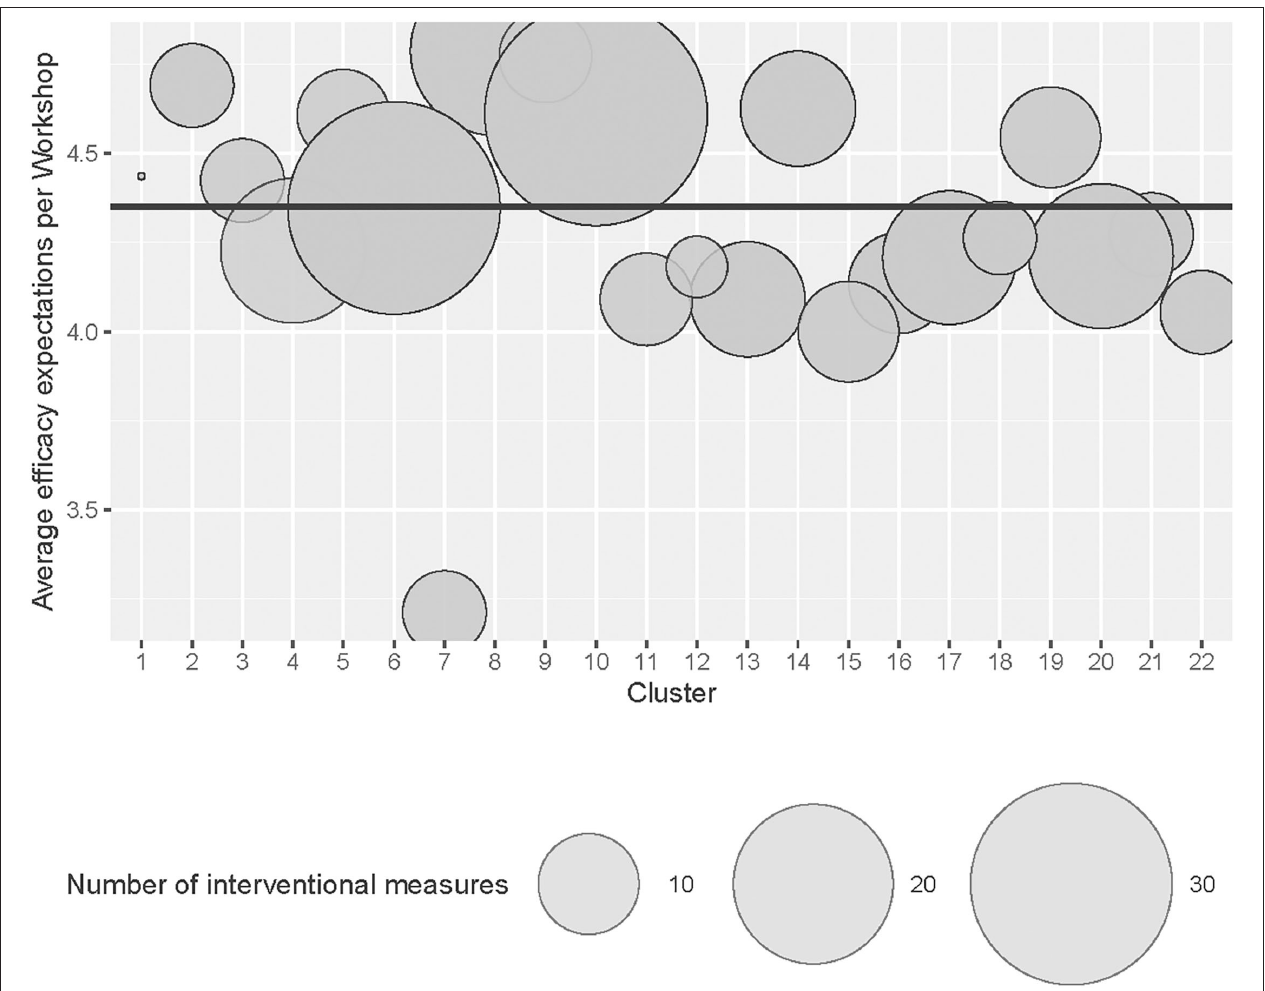
FIGURE 2 | Number of interventional measures across workshop groups